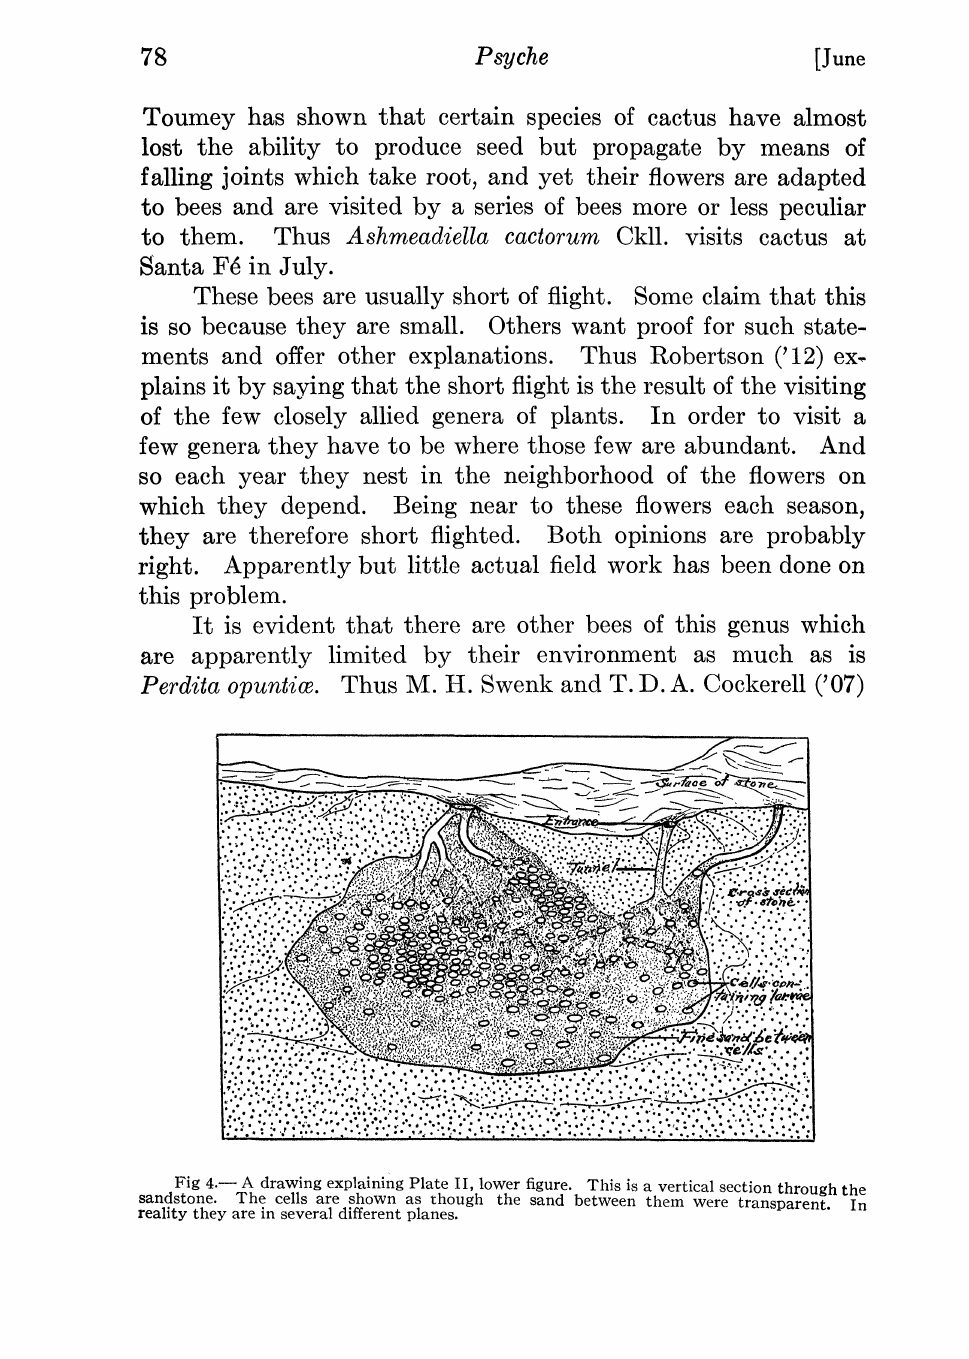
Fig 4.-- A drawing explaining Plate II, lower figure This is a vertical section through the sandstone. The cells are shown as though the sand between them were transparent. In reality they are in several different